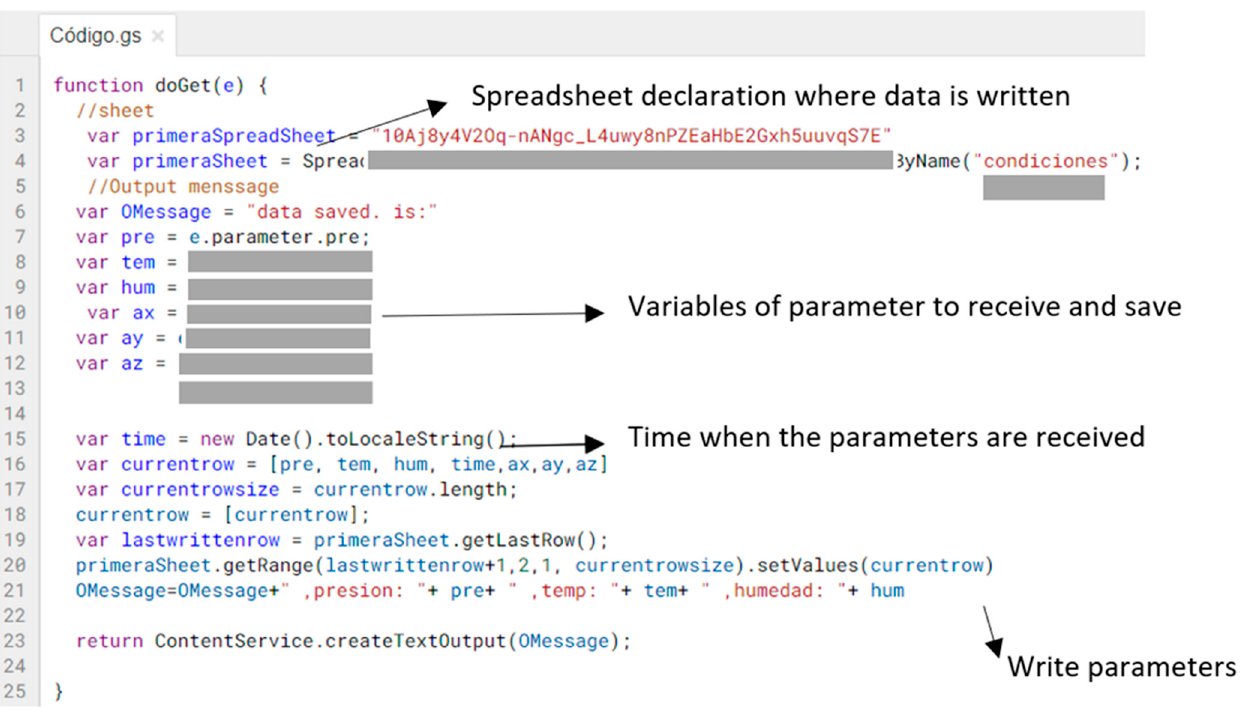
Figure A1. DoGet script for sending data to the Cloud.